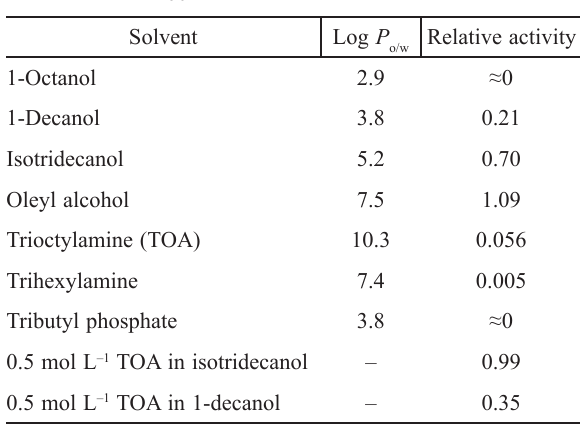
Table 1 – Toxicity of organic solvents to Rhizopus oryzae IAM